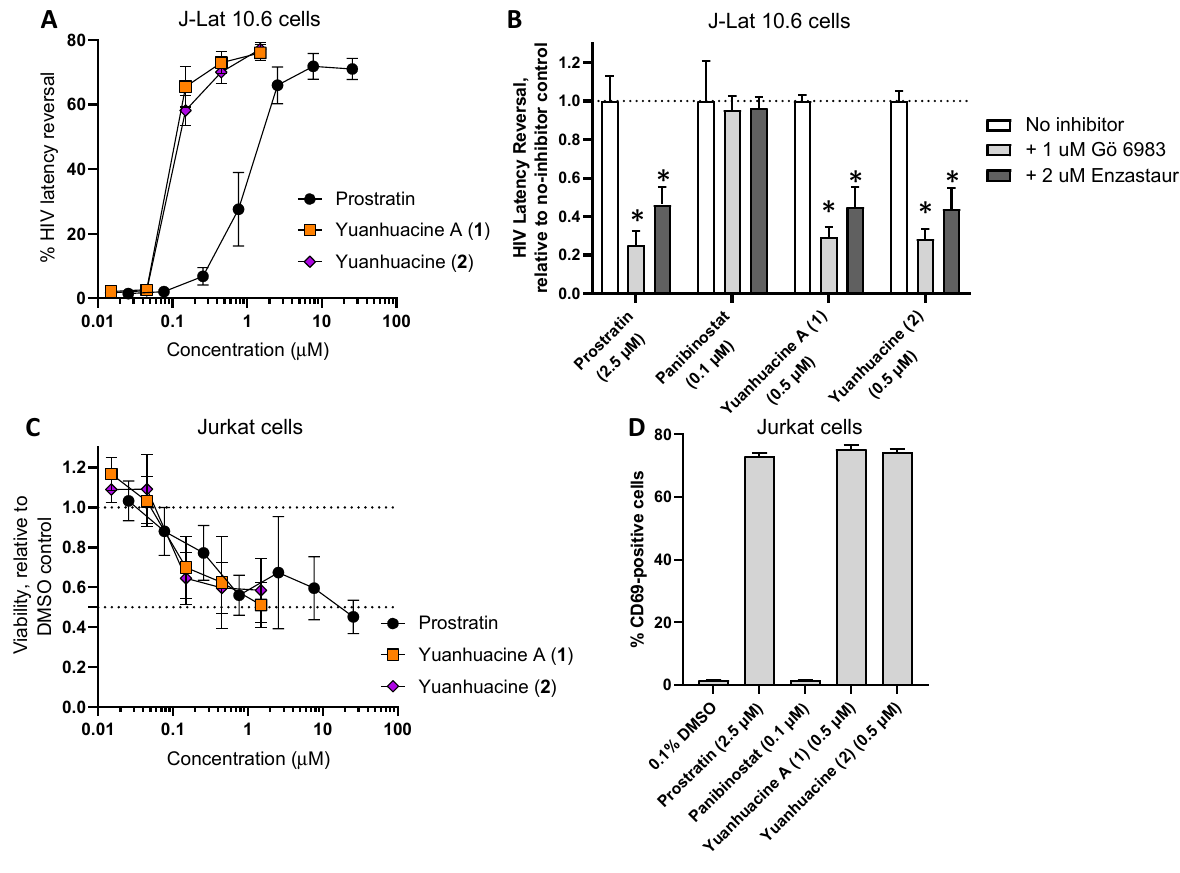
Figure 5. ( A ) Effects of compounds on HIV provirus expression in J-Lat 10.6 T cells following 24 h incubation, as measured by GFP reporter expression by flow cytometry. ( B ) Effects of pan-PKC inhibitor Gö 6983 (1 µ M) and PKC β inhibitor enzastaurin (2 µ M) on LRA-induced latency reversal. ( C ) Effects of compounds on cell viability in Jurkat T cells after 24 h, as measured by resazurin dye. ( D ) Effects of compounds on Jurkat T cell activation, as measured by CD69 expression, following 24 h incubation with compounds. Results denote the mean ± SD of at least 3 independent experiments. *, p < 0.01 by Student’s two-sided t test.